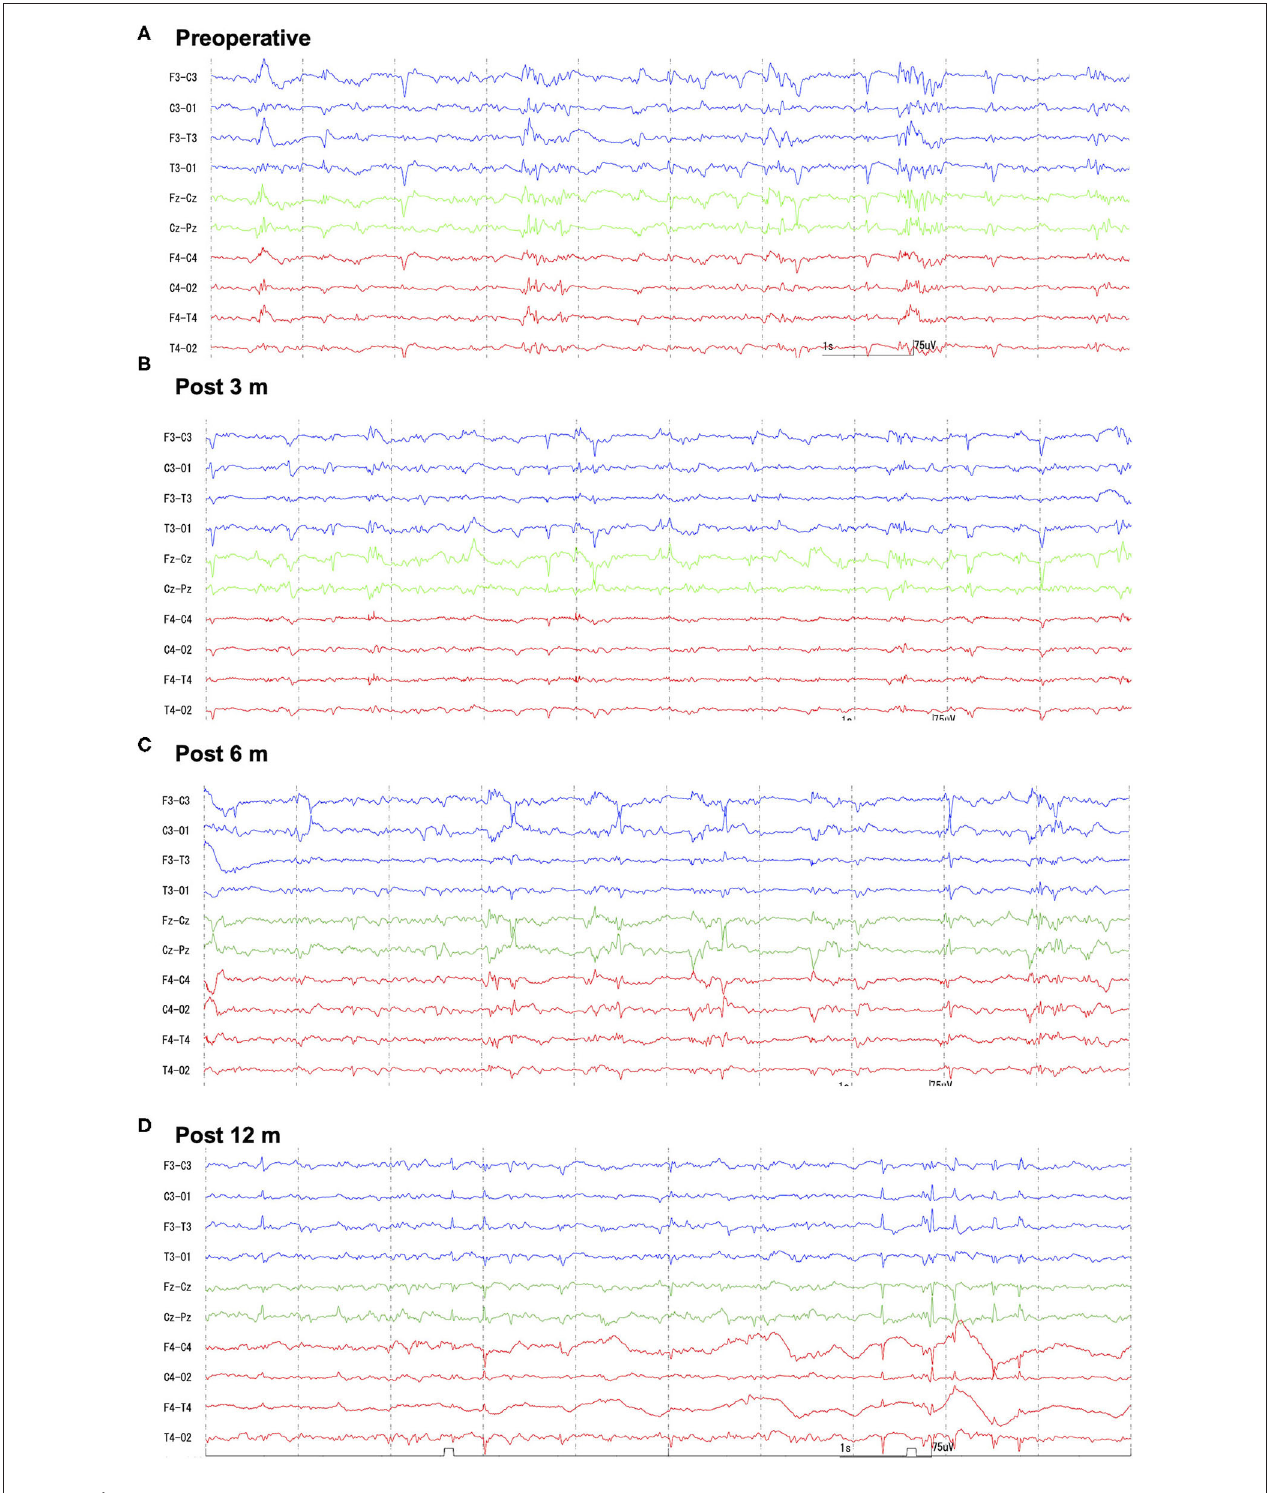
FIGURE 1 | Preoperative and follow-up scalp EEGs. Preoperatively (A) generalized spikes and multiple spike complex were frequently observed with phase reversal at the central region (C3, Cz, C4). Follow-up EEGs [ (B) 3-months; (C) 6-months; (D) 12-months after surgery] showed decreased spike frequency, and some small spikes were found to be limited to one hemisphere. However, large spikes were always bilaterally synchronized. Bipolar montages: blue traces are left (F3-C3, C3-O1, F3-T3, T3-O1), greens are midline (Fz-Cz, Cz-Pz), and reds are right (F4-C4, C4-O2, F4-T4, T4-O2). Sensitivity = 15 µ V, Time constant = 0.1, High-cut filter = 60Hz, AC filter =